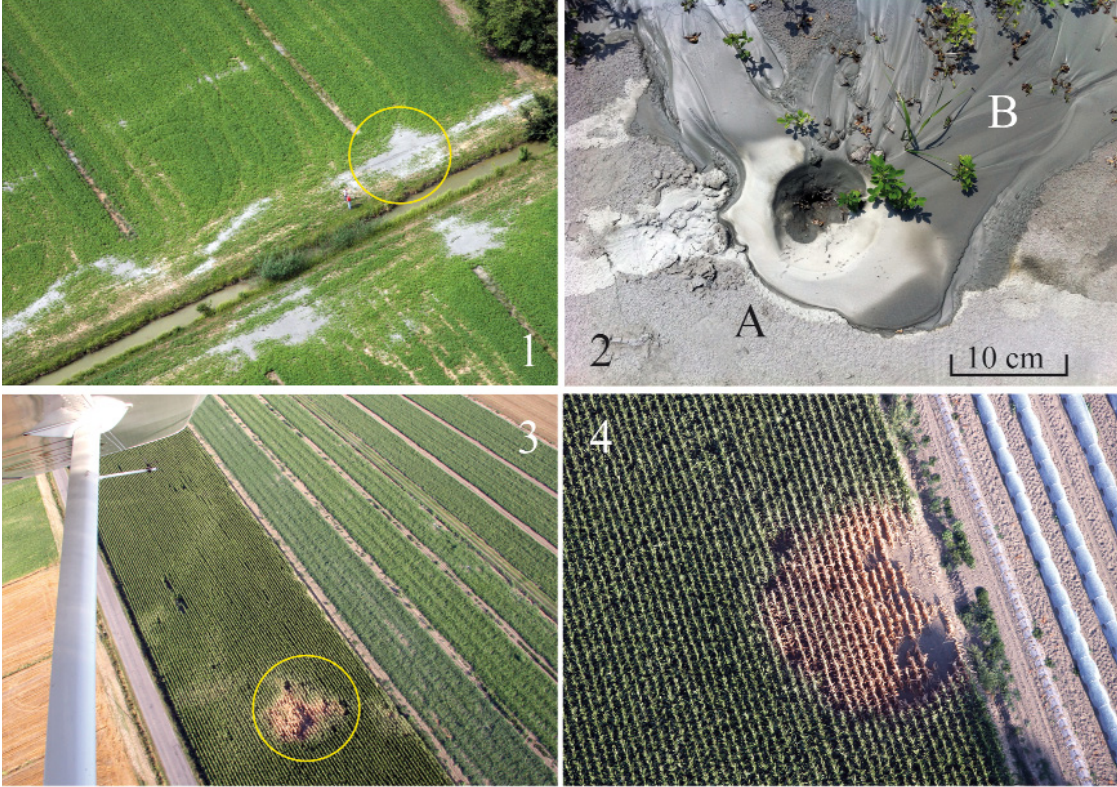
Figure 5. 1) Several 'sand volcanoes' near San Martino Spino (Modena Province). 2) Vertical close-up detail from panel (1) (yellow circle): the 'new' mud (B) erupted after the May 29 mainshock covered the sand (A) that erupted on May 20. 3), 4) Evidence of effects of dubious origin in corn plantations near Medolla (N 44.85˚; E 011.08˚), near to the May 29 epicenter.